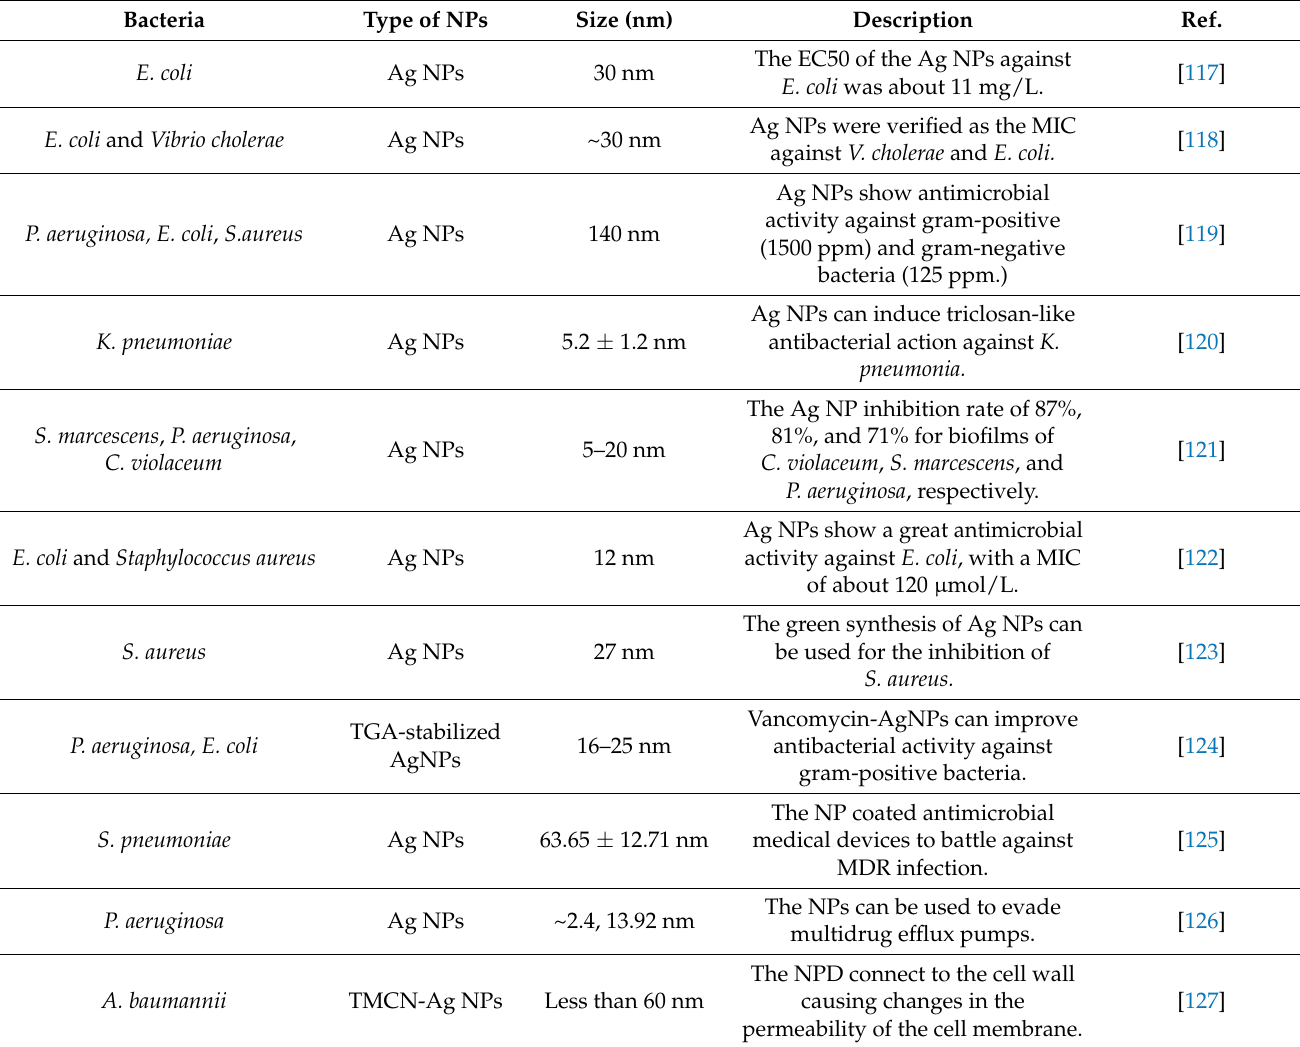
Table 1. Other examples of the application of Ag NPs in antimicrobial resistance activity (AMR).